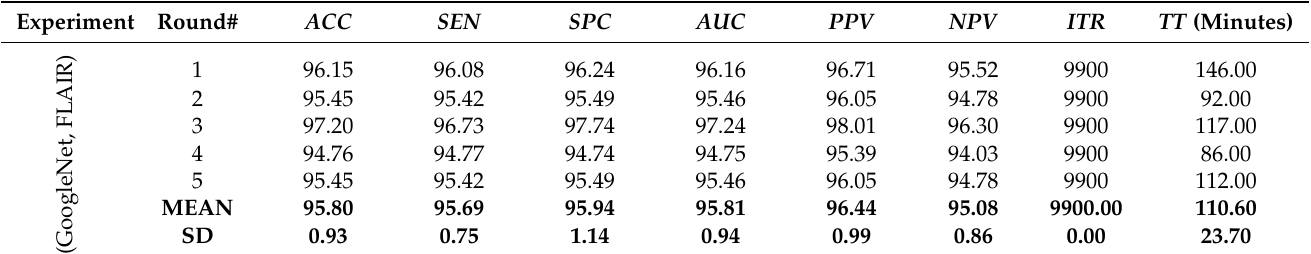
Table A18. Test results of five-folds of the experiment (GoogleNet, FLAIR).